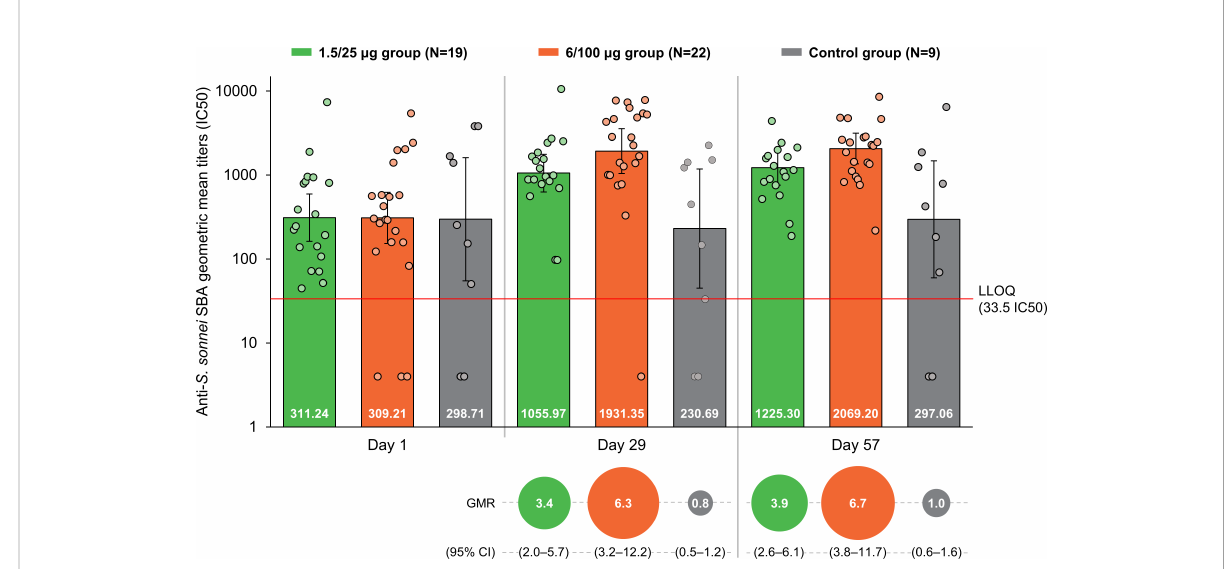
FIGURE 2 SBA geometric mean titers and within-participant geometric mean ratios at all time points (full analysis set). SBA, serum bactericidal activity; GMR, geometric mean ratio; CI, con fi dence interval; IC50, reciprocal of the serum dilution that results in killing 50% of the bacteria present in the assay; LLOQ, the lower limit of quanti fi cation of the assay; Day 1, pre-vaccination; Day 29, 28 days post- fi rst vaccination; Day 57, 28 days post-second vaccination; 1.5/25 µg group, participants receiving the 1.5/25 µg O antigen/protein vaccine formulation; 6/100 µg group, participants receiving the 6/100 µg O antigen/protein vaccine formulation; Control, participants receiving a quadrivalent meningococcal conjugate vaccine at Day 1 and a vaccine against tetanus, diphtheria, and acellular pertussis at Day 29. Points represent individual data. Numbers at the base of the bars are the GMT values. Error bars depict 95% CIs. Note: Half the LLOQ (16.75 IC50) was assigned to participants with antibody titers below the LLOQ when calculating SBA